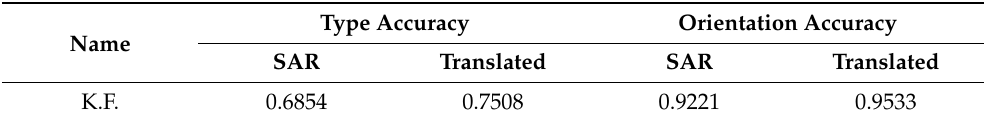
Table 2. Results of manual target recognition experiment. Average results of six SAR professionals are in